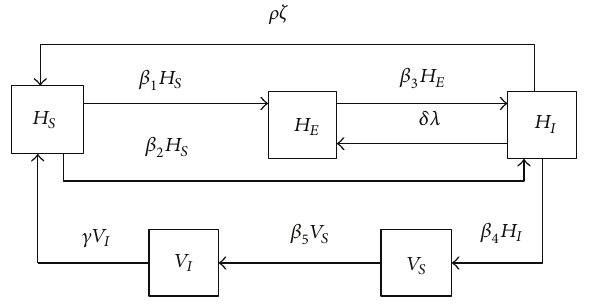
Figure 2: Model transfer diagram for